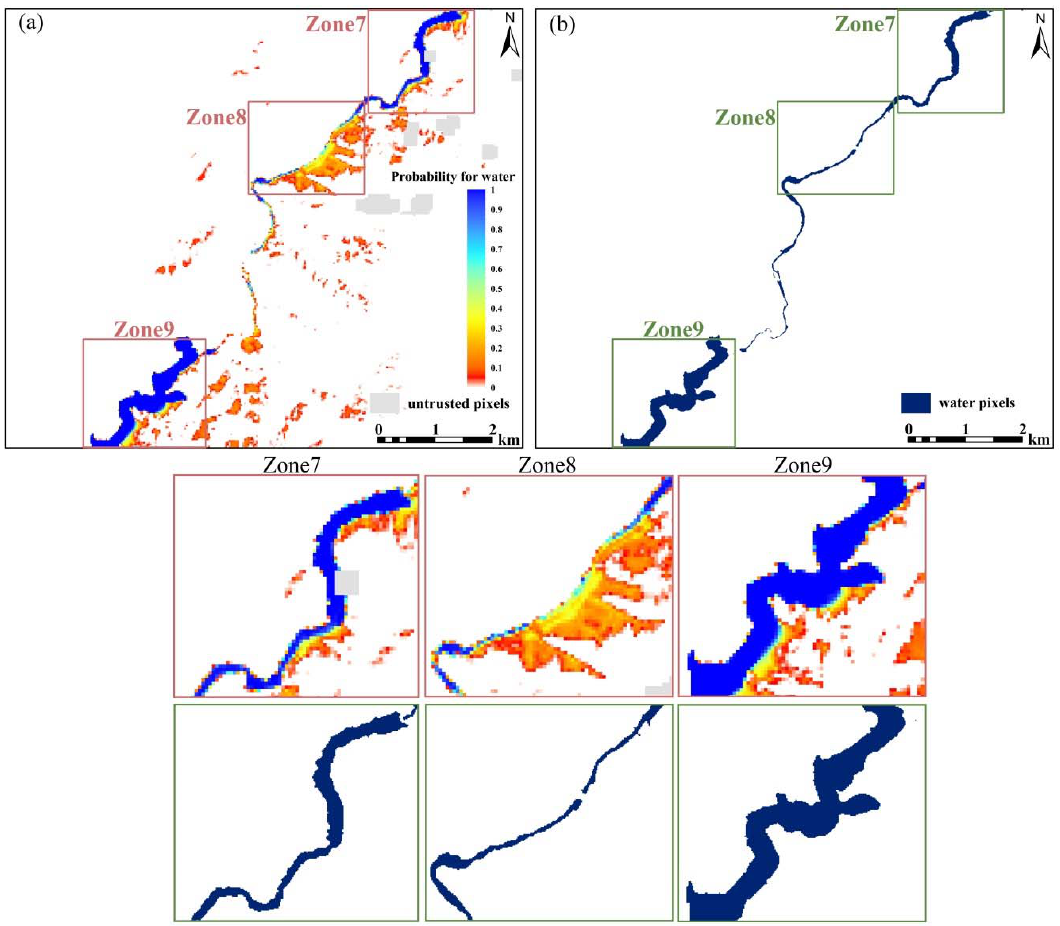
Figure 6. ( a ) The posterior probability map in the Yingluoxia reach of the Heihe River and ( b ) the referencing water map derived by visually interpreting Sentinel-2 images.